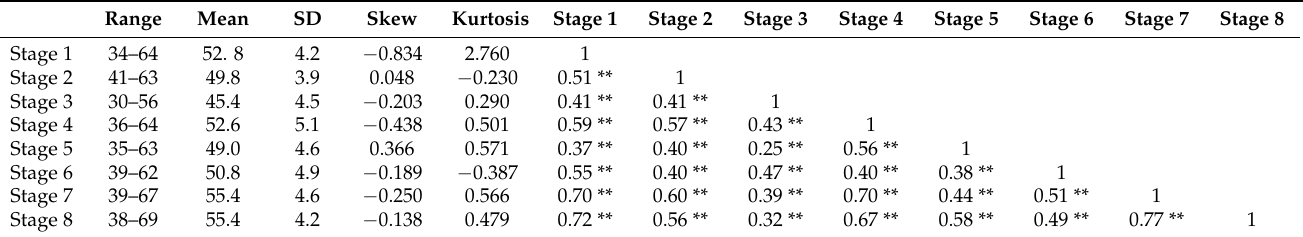
Note: stage 1: trust versus mistrust, stage 2: autonomy versus shame, stage 3: initiative versus guilt, stage 4: industry versus inferiority, stage 5: identity versus role confusion, stage 6: intimacy versus isolation, stage 7: generativity versus stagnation, stage 8: integrity versus despair. ** p < 0.01.